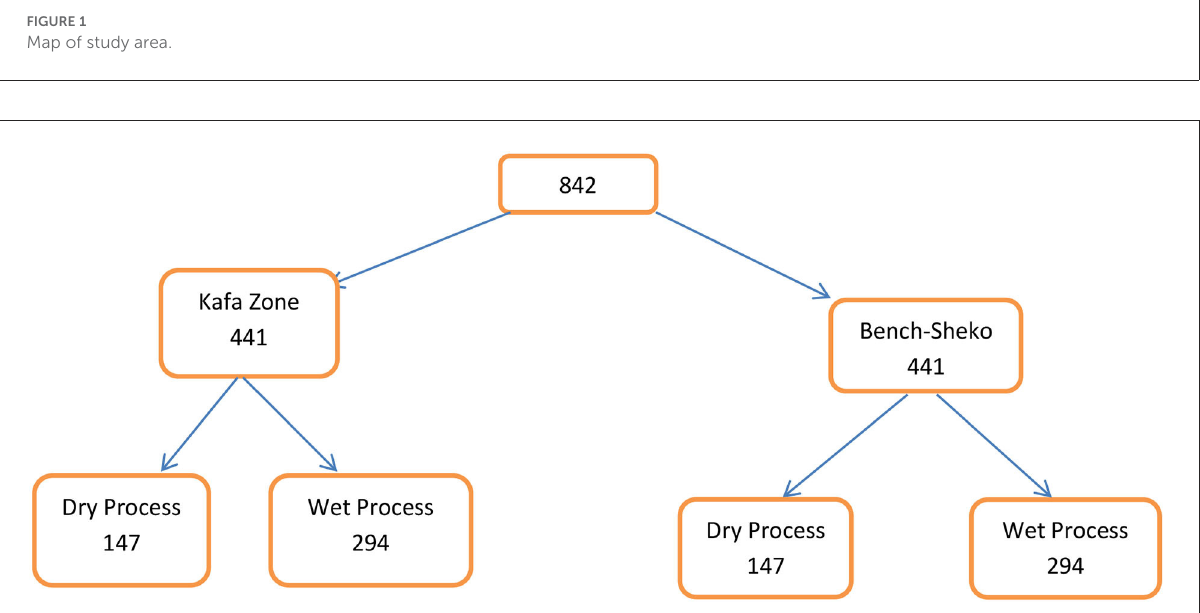
FIGURE2 The schematic presentation of the sampling process.